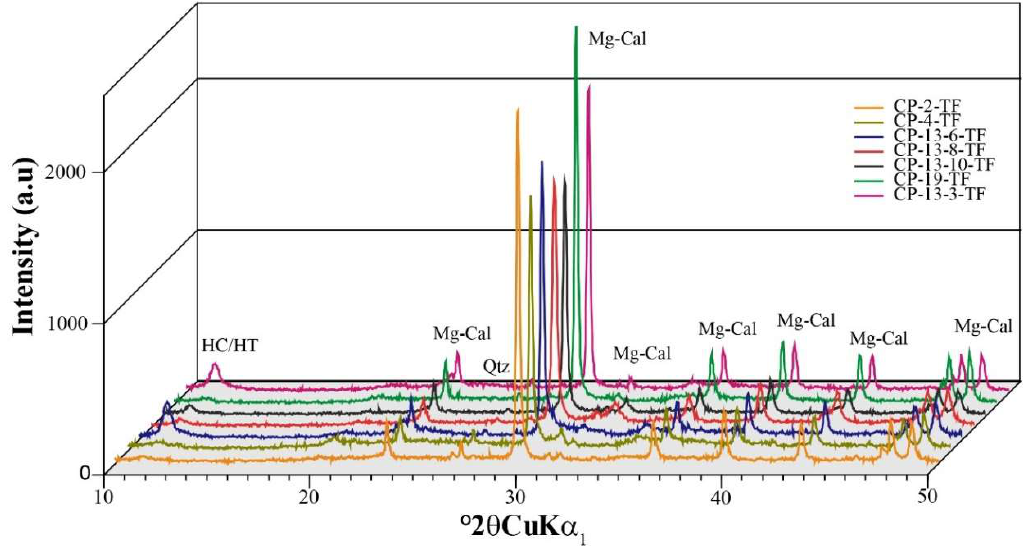
Figure 8. Lime binder cycles. ( a ) lime cycle and ( b ) proposal of dolomitic lime cycle of impure dolostone.